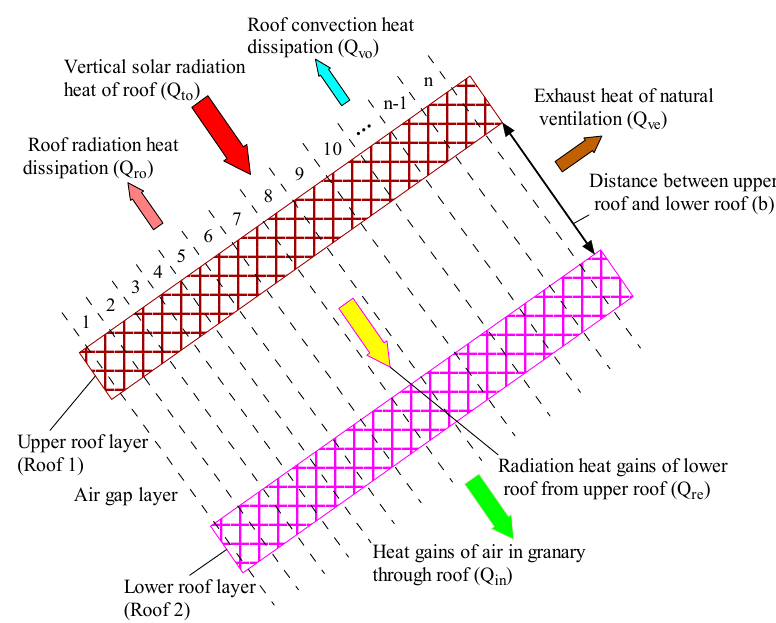
Figure 2. Schematic diagram of heat transfer of a double-skin roof.